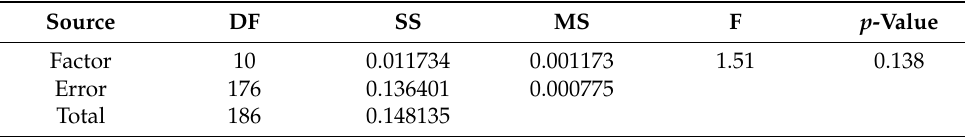
Table 2. Analysis of variance of the effectiveness factor versus the reactor